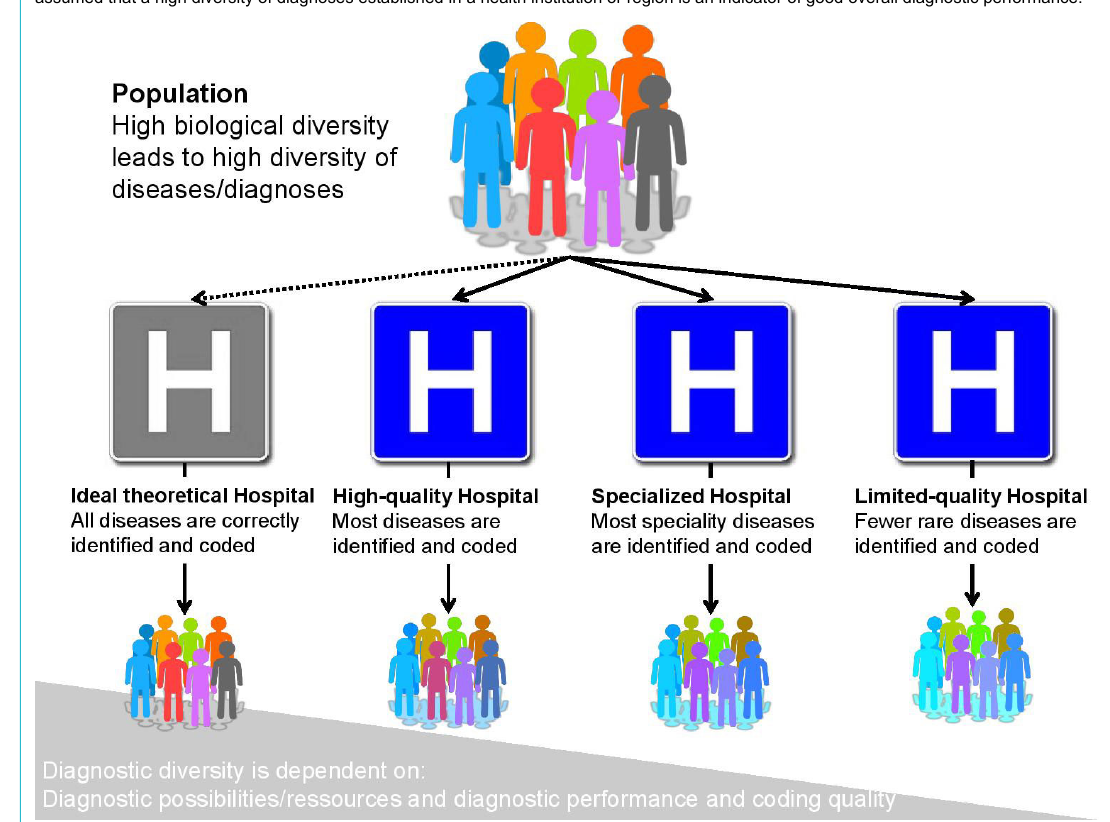
Figure 1: Diagnostic diversity as a measure of overall diagnostic performance – study hypothesis. It can be expected that the diseases occurring in a population reflect the biological diversity of humans with their diverse genetic make-up and different exposures. Thus, it can be assumed that a high diversity of diagnoses established in a health institution or region is an indicator of good overall diagnostic